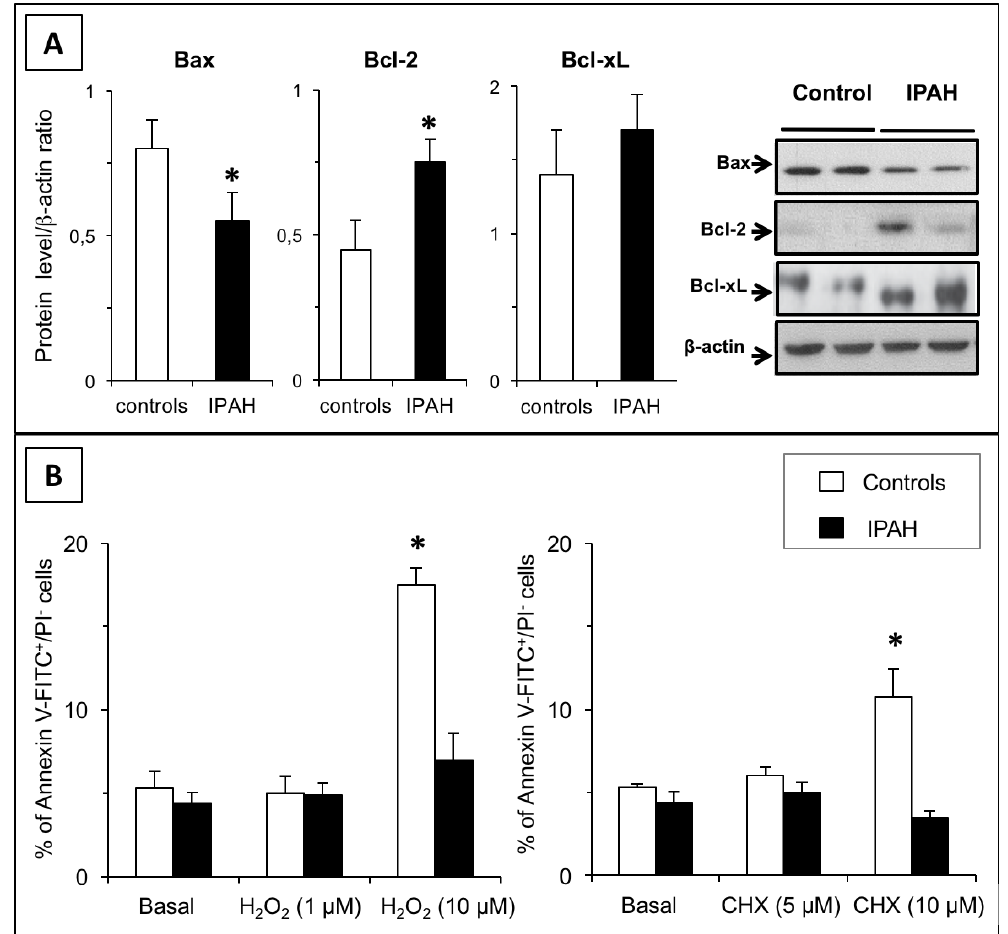
Figure 3. Apoptosis resistance in IPAH. ( A ) Expression levels of pro- and anti-apoptotic proteins Bax, Bcl-2, and Bcl-xL in PASMCs from controls and from patients with IPAH ( n = 6 in each group). ( B ) The effect of H 2 O 2 (1 – 10 µM) or cycloheximide (5 – 10 µM) on apoptosis, as determined by annexin V staining. As shown, the two treatments induced apoptosis in control ( C )-PASMCs, while IPAH-PASMCs remained unresponsive. * p < 0.01 between controls and IPAH.